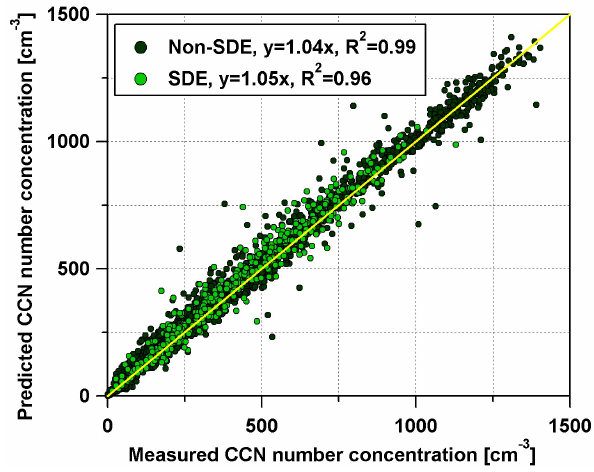
Fig. 10. Predicted vs. measured CCN number concentration during non-SDE period (dark green) and the SDE period (light green). All supersaturations are included. The yellow line represents the one- to-one ratio.